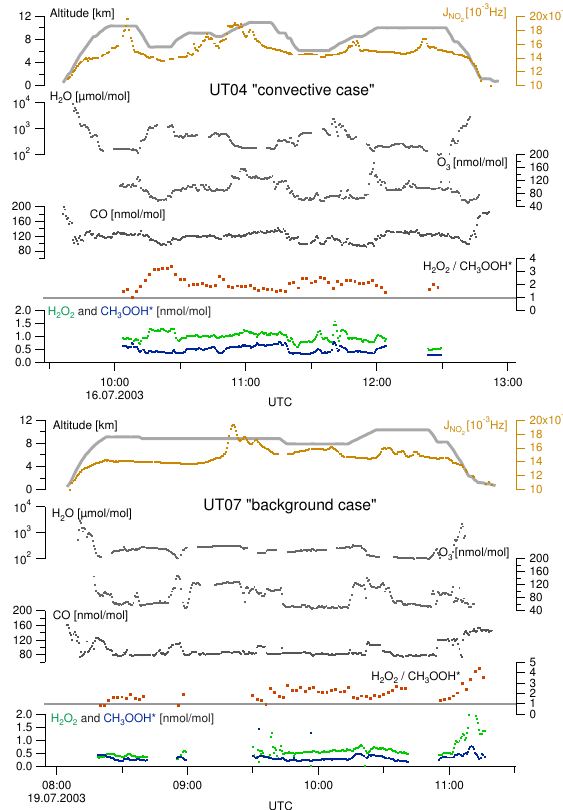
Fig. 14. The usage of the H 2 O 2 / CH 3 OOH ∗ ratio as indicator for recent convective influence on an airmass. Time series of HOOVER flights 07 and 08 representing the “convective” (H 08) and “back- ground” (H 07) case. The peroxide ratio is in the range of 2-4 over- all for flight H 08, and the effect of convective injection can be seen in the grey shaded boxes in CO, water vapour and enhanced perox- ide levels in the upper troposphere. In contrast, the grey shaded box during flight 07 shows a chemically aged airmass with low and flat time series for CO, O 3 , water vapour and peroxide but nevertheless shows peroxide ratios around and even below unity.